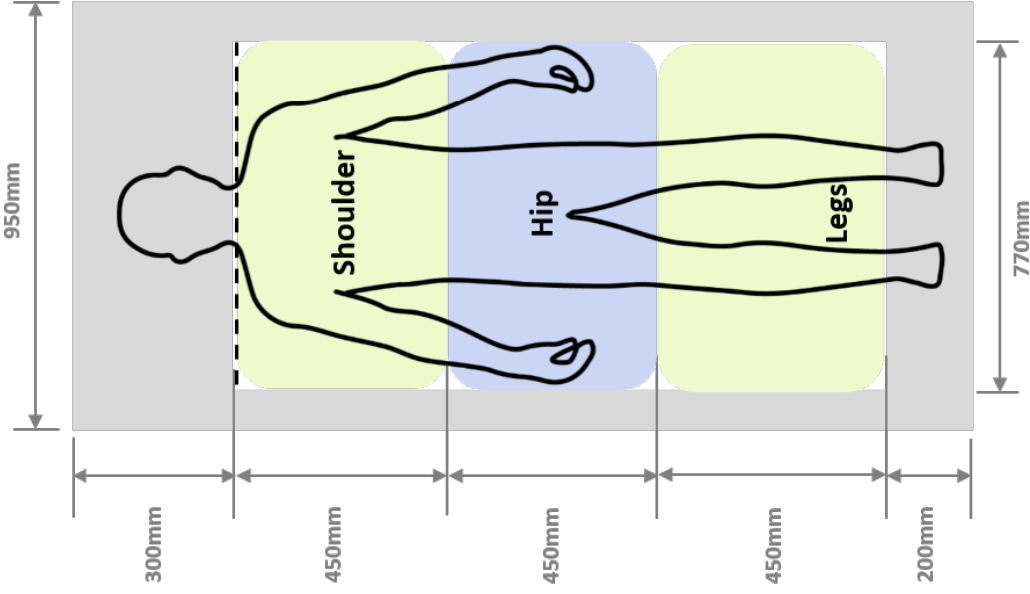
Figure 2. Location and size of air cells in the mattress.